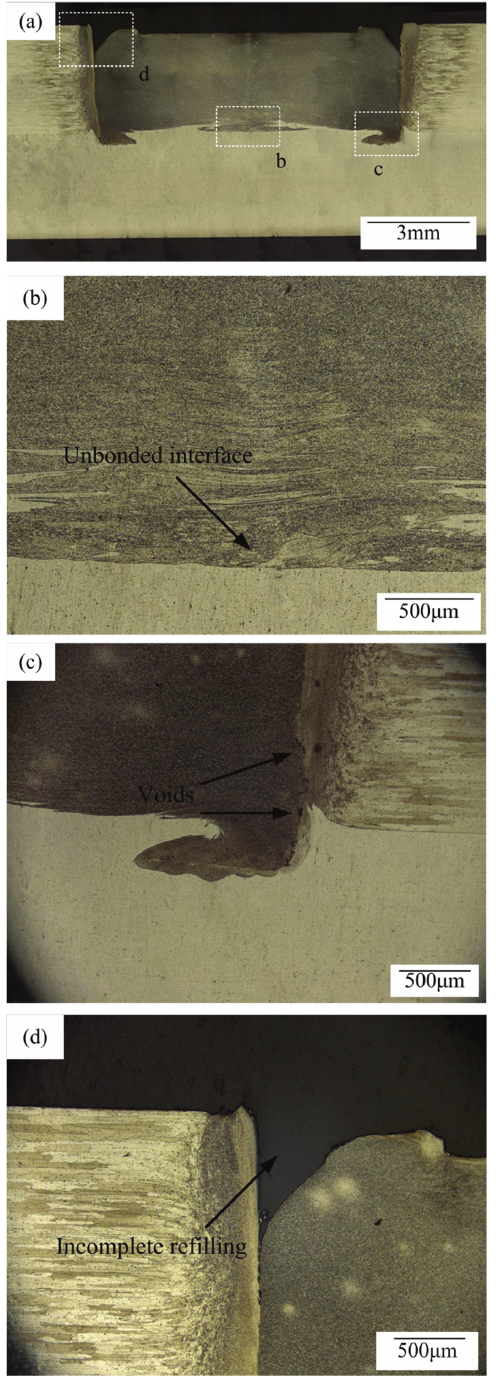
Figure 2: Microstructure of the joint using 7075 as the upper sheet (a) cross section, (b) un-bonded interface (c) void and (d) incomplete refilling.